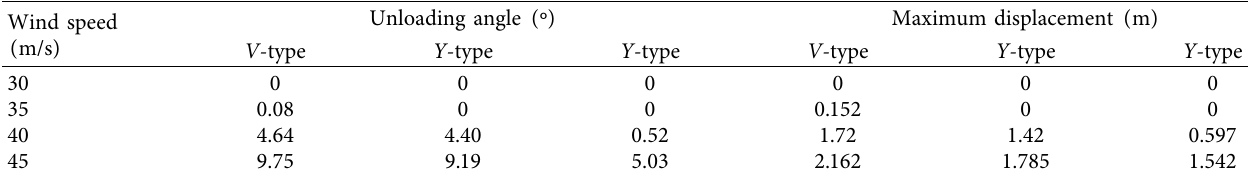
Table 8: Te comparison of analysis results between the no. 5 and no. 6 insulator strings.